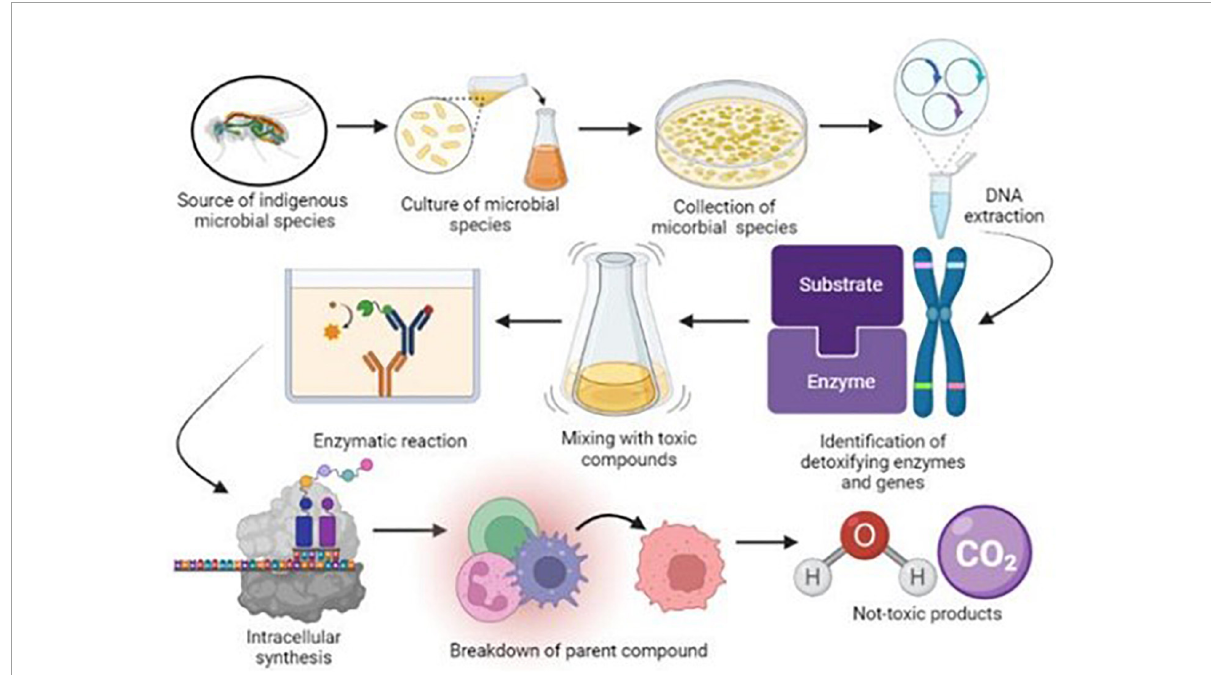
FIGURE2 Schematic diagram of isolation of insect gut microbial species and their functions in biodegradation of environmental